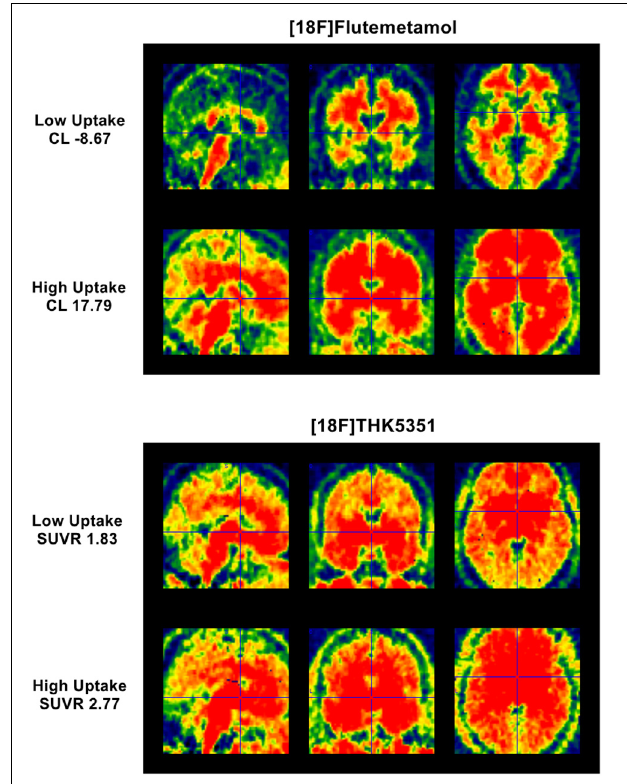
FIGURE 1 | Parametric [18F]Flutemetamol and [18F]THK5351 uptake. (Top) panel represents parametric [18F]Flutemetamol binding estimation for subject having lowest Centiloid value (–8.67 CL) and for subject having highest Centiloid value (17.79 CL) over a mask covering mostly neocortical regions. (Bottom) panel represents parametric [18F]THK5351 binding estimation for subject having lowest SUVR value (1.83 SUVR) and for subject having highest SUVR value (2.77 SUVR) over a mask covering entorhinal cortex and